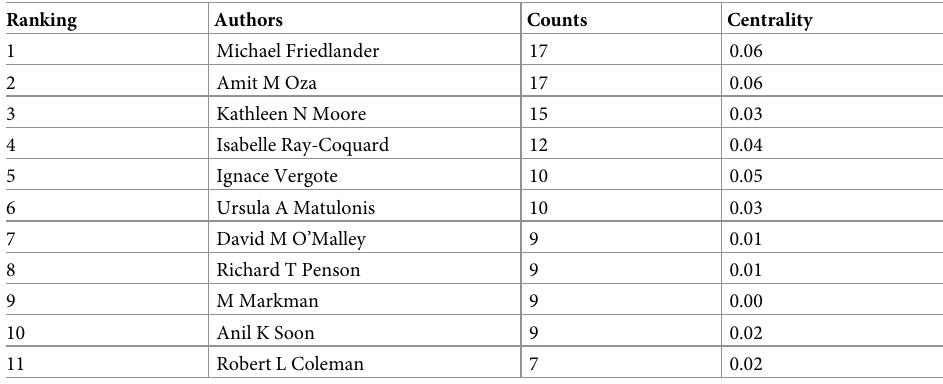
Table 2. Core authors of researching CRF in ovarian cancer survivors.